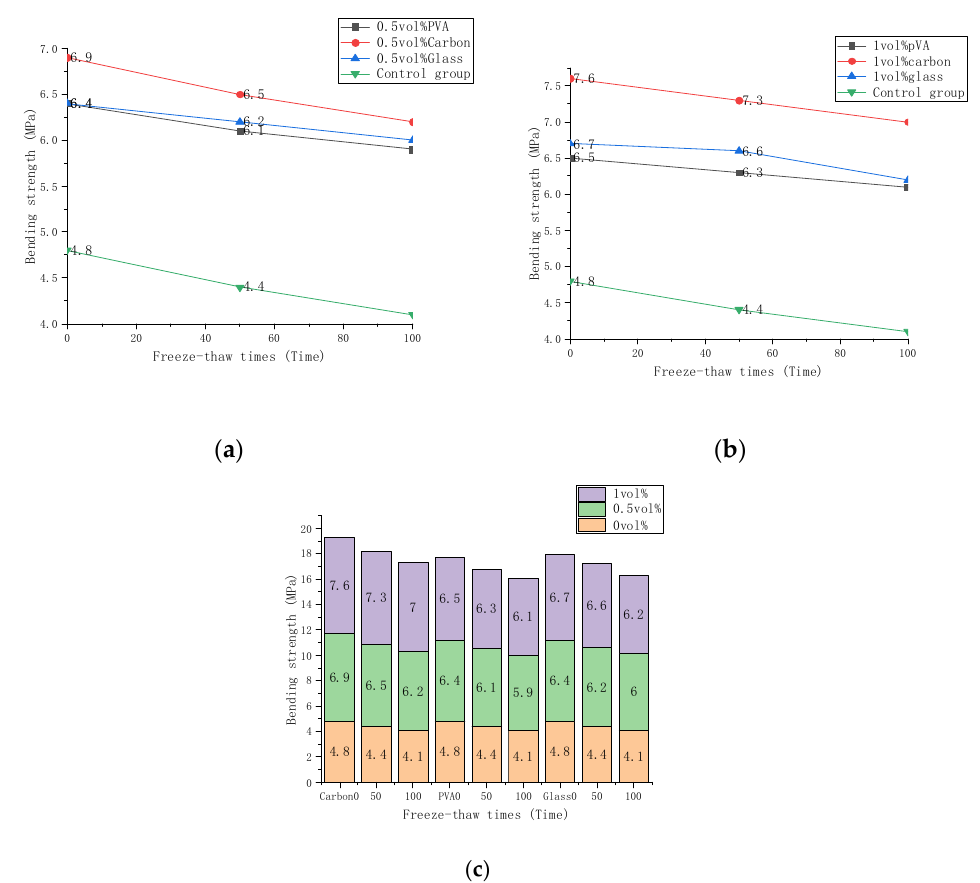
Figure 8. Bending strength changes with the number of freeze-thaw cycles: ( a ) Bending strength of 0.5vol%; ( b ) Bending strength of 1vol%; ( c ) The bending strength of 0vol%, 0.5vol%, 1vol% com- parison.